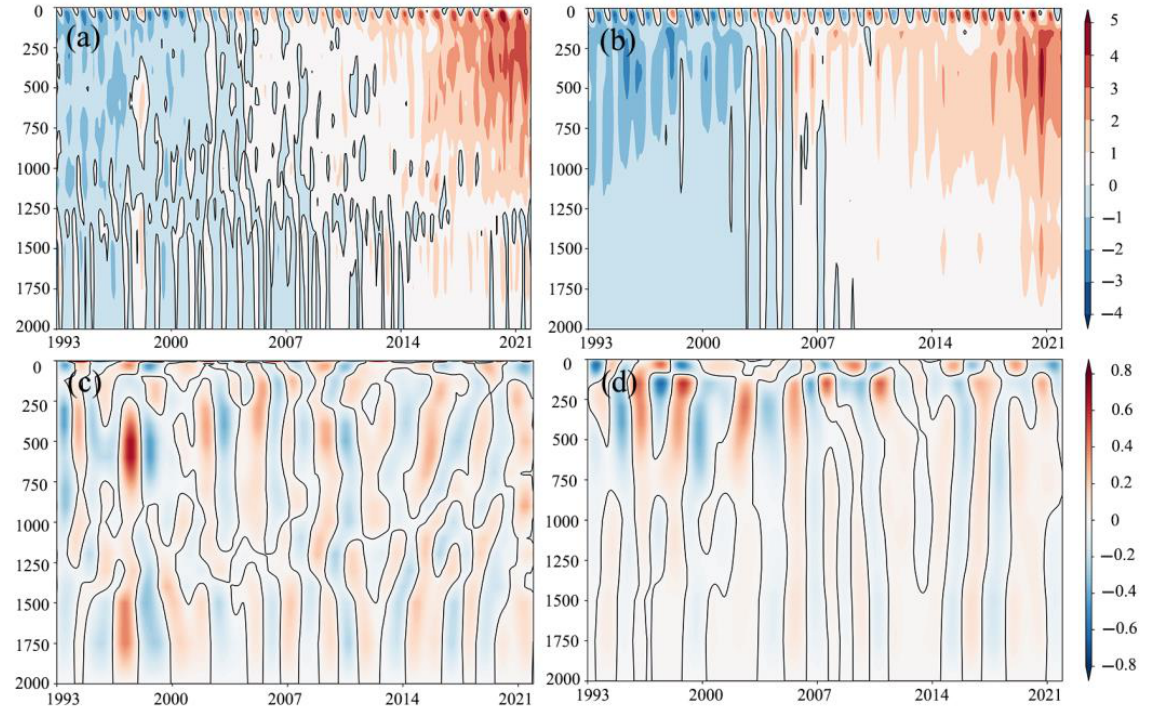
Figure 8. The global OHC (top, unit: 10 7 J m −2 ) and OHU (bottom, unit: W m −2 ) as a function of depth and time from 1993 to 2021 from the ( a , c ) OPEN and ( b , d ) IAP datasets.